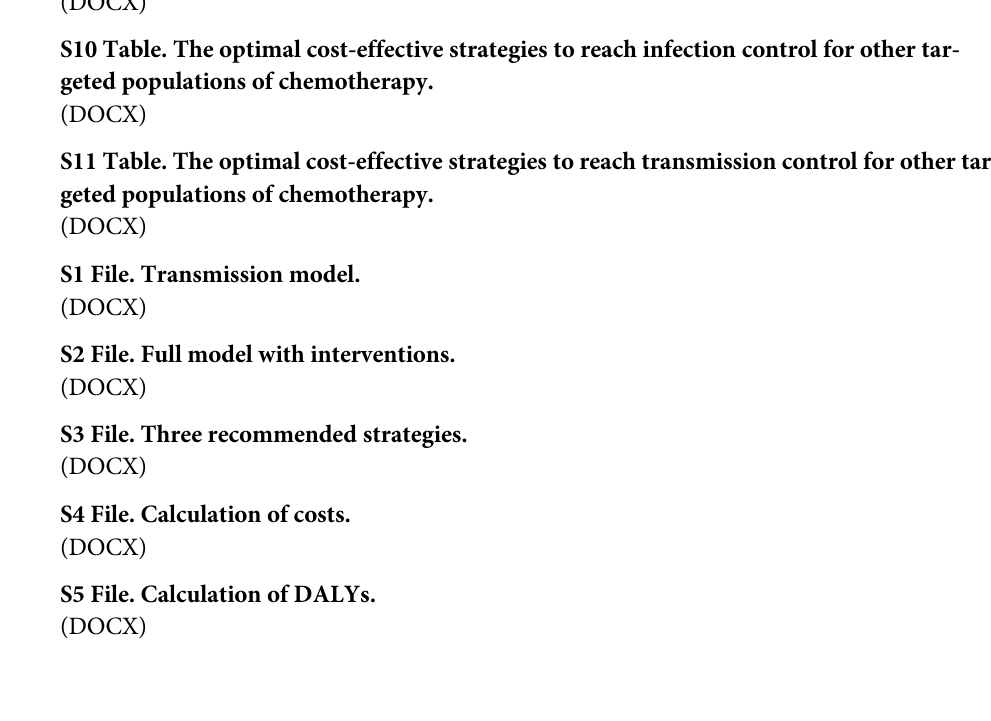
S1 Table. Descriptions of model parameters (unit: day -1 ). S2 Table. Observed prevalence of C. sinensis infection among groups of people with differ- ent frequencies of raw fish consumption in Fusha Town. S3 Table. The prior distributions and posterior estimations of model parameters (unit: day -1 ). S4 Table. Values set for compliance of chemotherapy among different kinds of targeted population. S5 Table. Values of intervention parameters of the current recommended control strate- gies. S6 Table. Costs of each aspect of the control strategies. S7 Table. Simulation results under the effective control strategies that could reach infec- tion control within 10 years. S8 Table. Simulation results under the effective control strategies that could reach trans- mission control within 10 years. S9 Table. The optimal cost-effective strategies with targeted population of any types and the upper coverage set to 90%. S10 Table. The optimal cost-effective strategies to reach infection control for other tar- geted populations of chemotherapy. S11 Table. The optimal cost-effective strategies to reach transmission control for other tar- geted populations of chemotherapy. (DOCX) S1 File. Transmission model. S2 File. Full model with interventions. S3 File. Three recommended